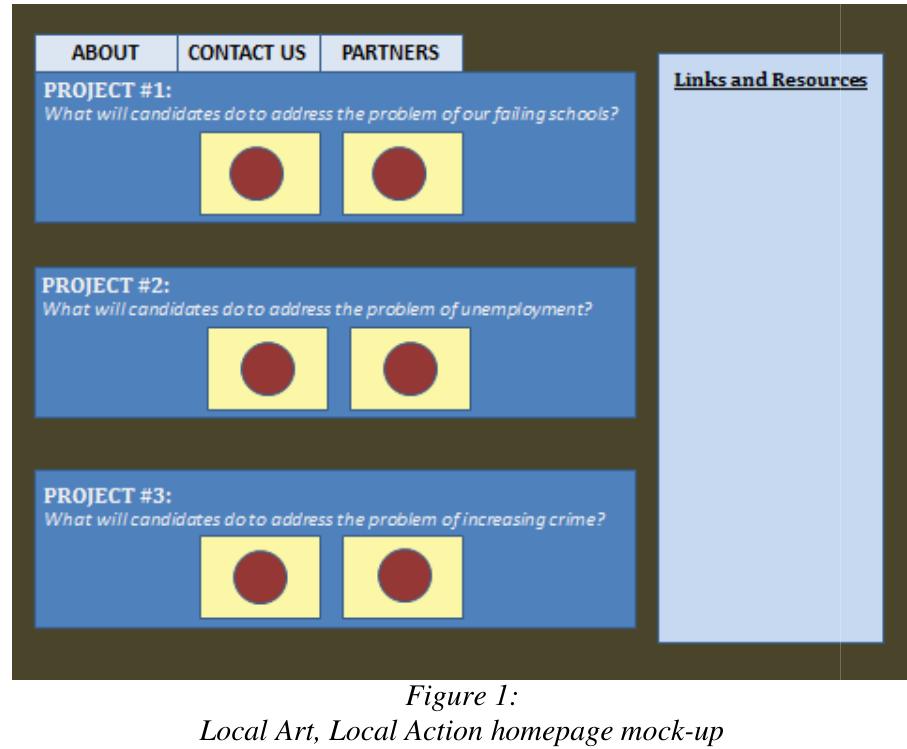
Local Art, Local Action homepage mock-up online forum, a stratified random sample of local